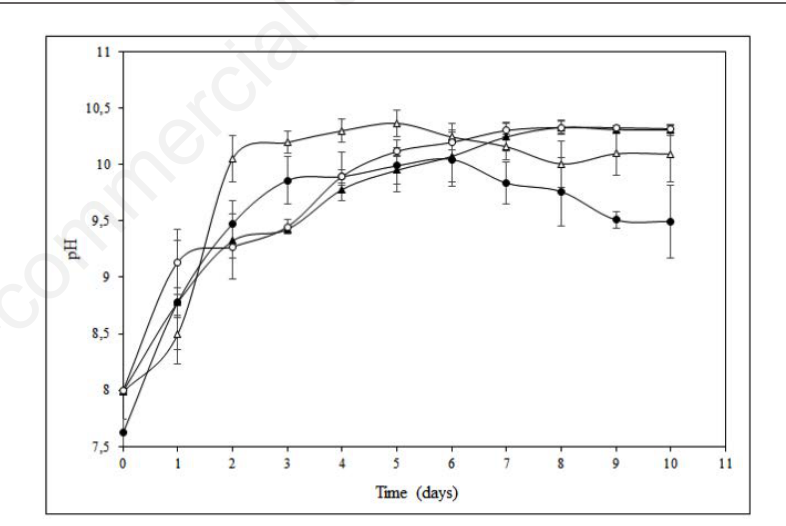
Figure 2. pH curves for Botryococcus braunii batch cultures supplemented with NaHCO 0 g L -1 ( filled circle ); NaHCO 0.5 g L -1 ( empty triangle ); NaHCO 3 gle ); NaHCO 2.5 g L -1 ( empty circle ). Error bar s represent SD (n 3 Table 1. Means of specific growth rates (SGR) and doubling times (DT) for different periods and in different conditions of sodium bicarbonate supplementation. Specific Growth Rate (day -1 )